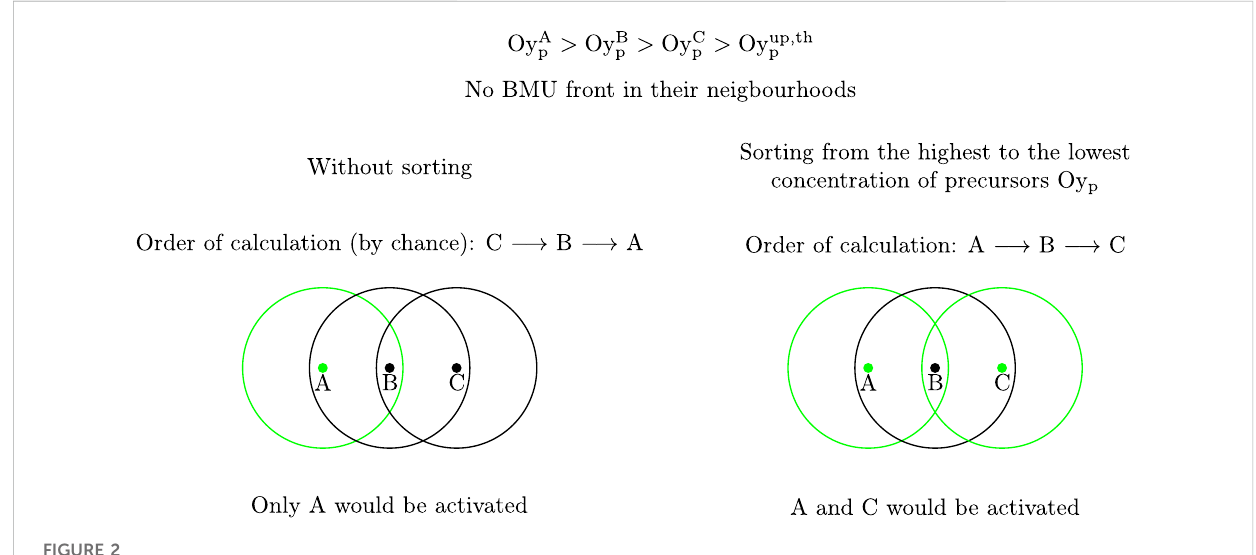
FIGURE 2 Rationale for sorting theIPs from the highest to the lowest concentration of precursors. The IPs whichwould be activated are represented ingreen. If a gradient of precursors concentration existed ( Oy A p > Oy B p > Oy C p > Oy up , th p ) , the IPs to be activated would depend on the order in which the FE software analyses the IPs. If this order were by chance C, B, A (left), only the IP A would be activated. C is analysed fi rst, but the algorithm detects that B (which is inside NBH C )hoststhemaximumofOy p within NBH C andpreventstheactivation atC.Next,Bisanalysed,buttheactivation isherepreventedbythe maximumofOy p within NBH B ,whichoccursatA.Therefore,onlyAisactivated.BysortingtheIPsbyOy p ,i.e.,A,B,C(right),thisrandomnessisavoidedand both A and C would be activated, since C ∉ NBH A